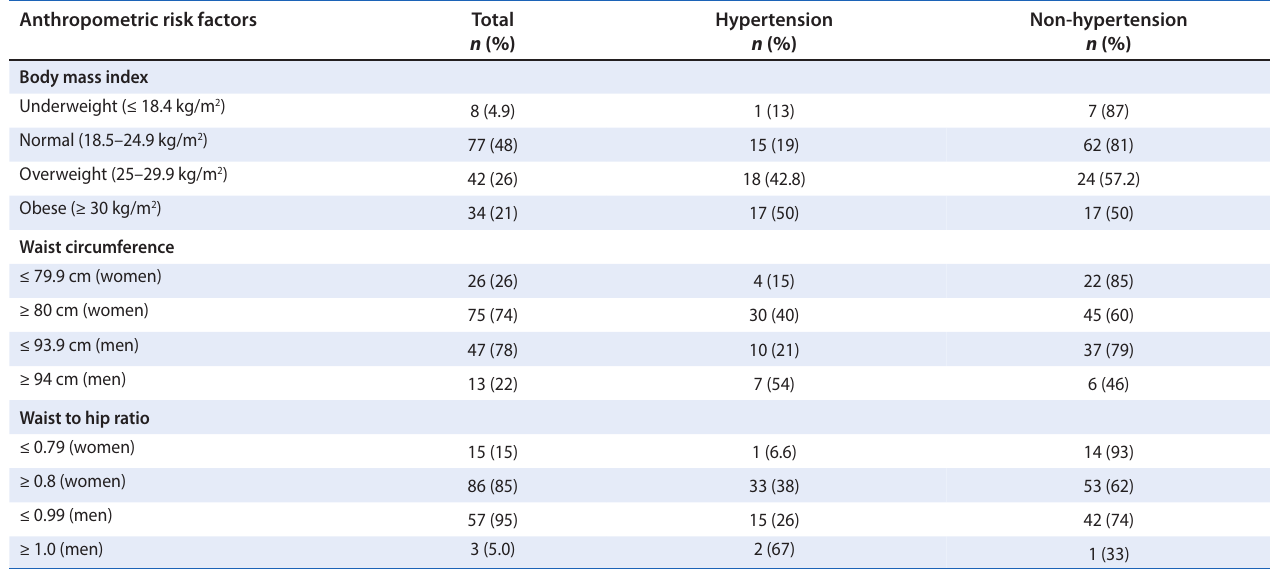
Table 3: Frequency distribution of elevated blood pressure, according to body mass index, waist circumference and waist to hip ratio in Kang participants, Botswana, in 2008 Anthropometric risk factors Total